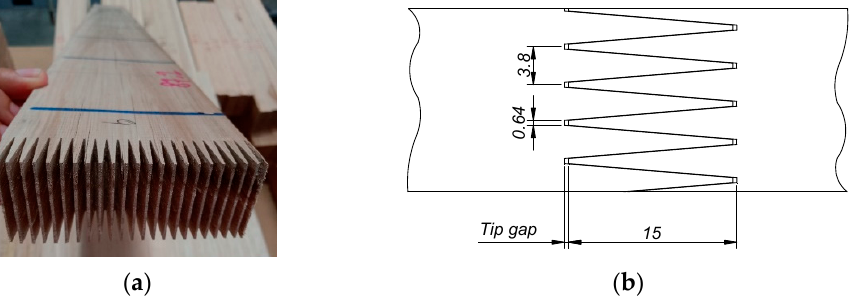
Figure 3. Geometries of finger joints: ( a ) photo of fingers; ( b ) profiles of the fingers (unit: mm).